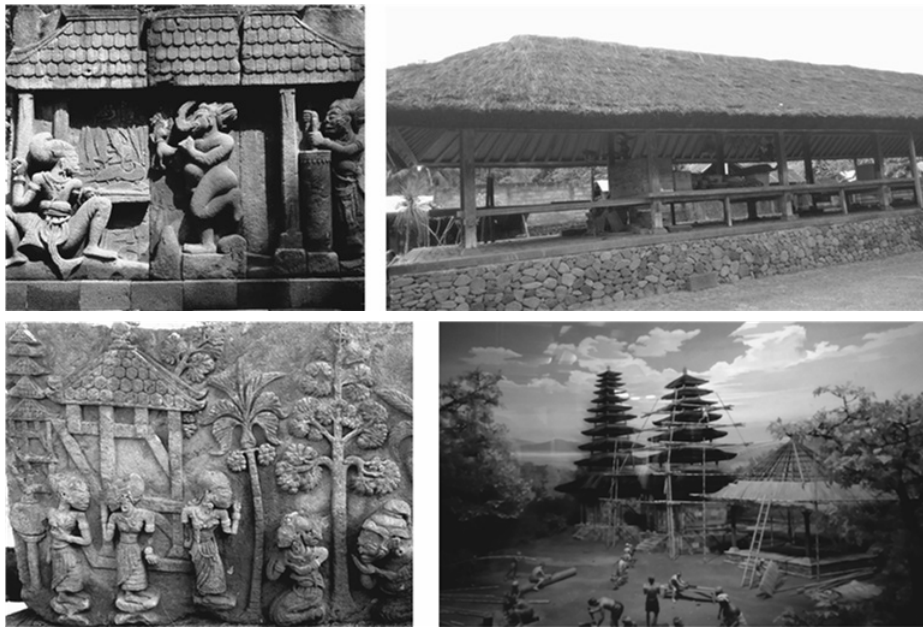
Figure 1. The long hip roof building in Sukuh temple relief and the recent construction in Bali (above) and the pyramidal roof with the background of the pura in the reliefs and Bali